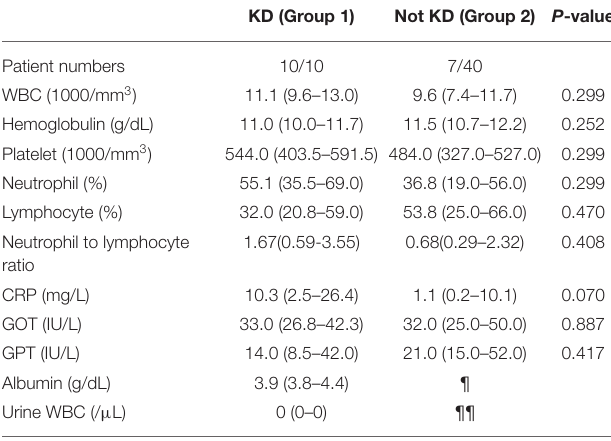
TABLE 2-2 | Patients’ laboratory data [median (IQR)] at second visit. KD (Group 1) Not KD (Group 2) P